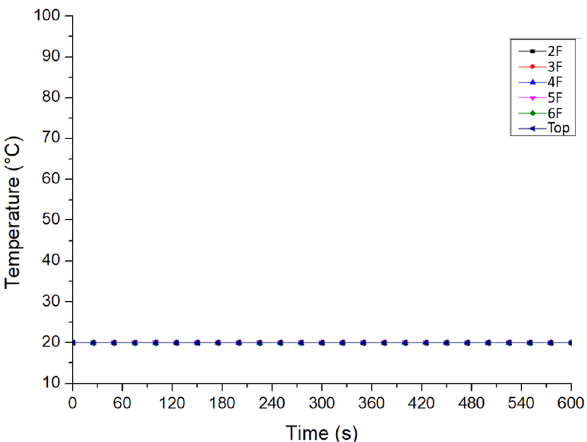
Figure 18. Temperature variation at the resident doors of No. 2 staircase on each floor (for Case